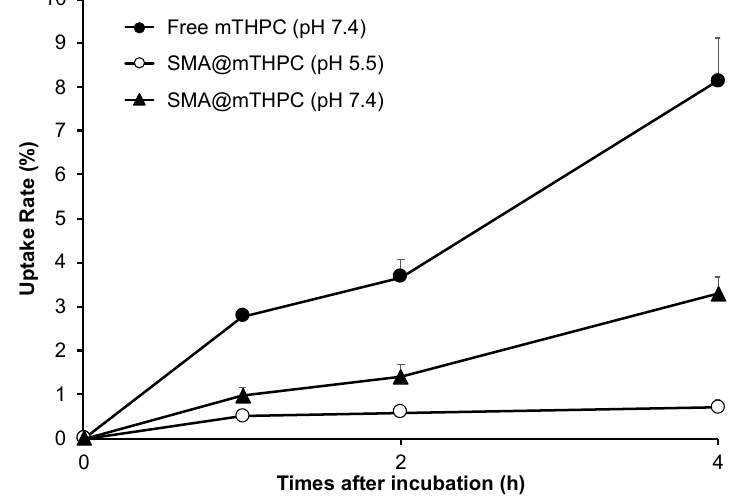
Figure 6. Intracellular uptake of SMA@mTHPC and free mTHPC in mouse colon cancer C26 cells. C26 cells were incubated with SMA@mTHPC or free mTHPC using media of different pH values (7.4 or 5.5). After indicated time, cells were collected, and the internalized mTHPC was quantified by measuring fluorescence intensity. Data are mean ± SD, n = 3. See text for details.